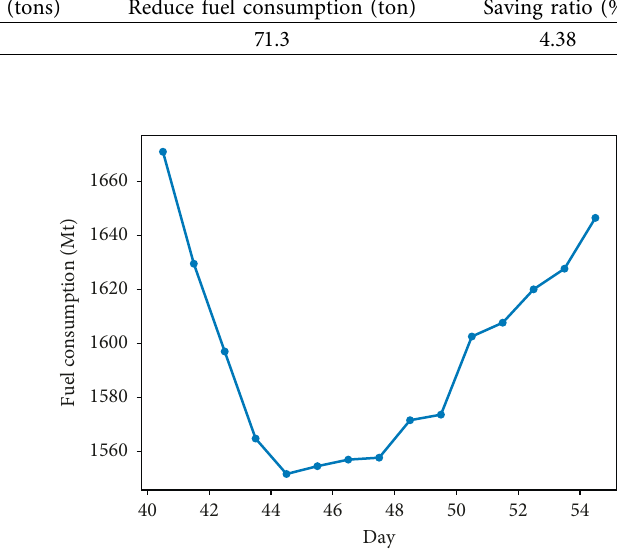
Figure 11: Fuel consumption with sailing time after speed optimisation.